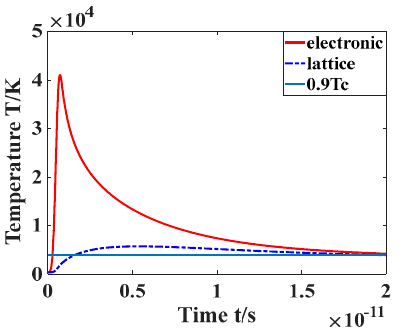
Figure 4. Lattice and electron temperature changes with time under threshold fluence.